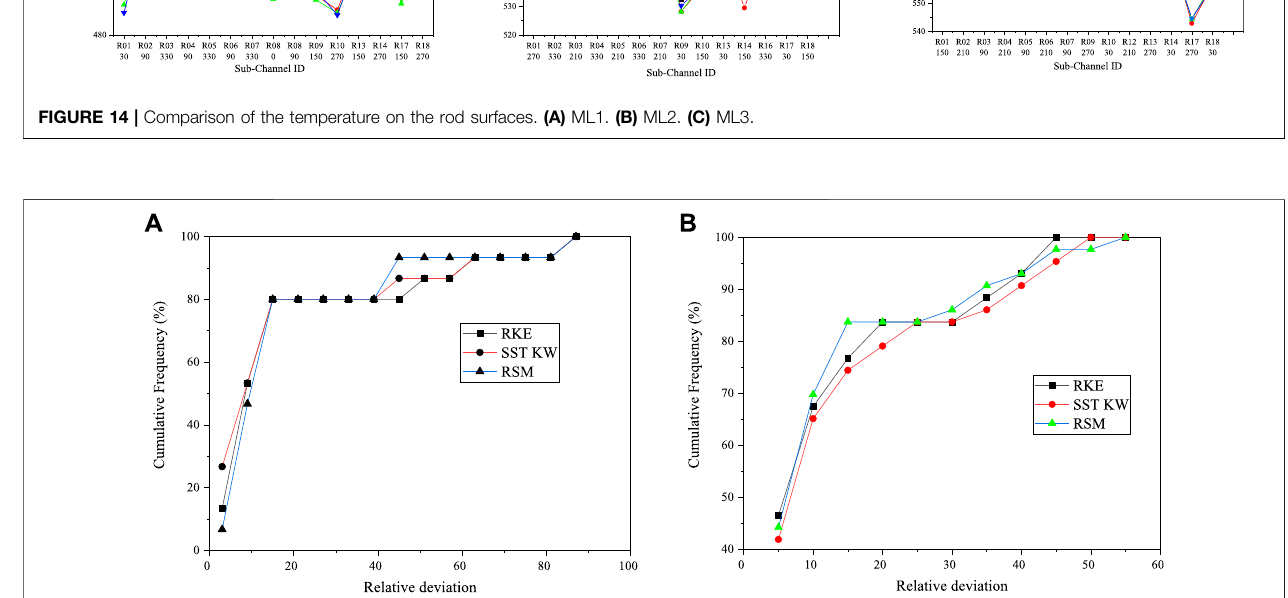
FIGURE 15 | Cumulative frequency distribution histogram. (A) Deviation for sub-channel temperature. (B) Deviation for rod surface temperature.